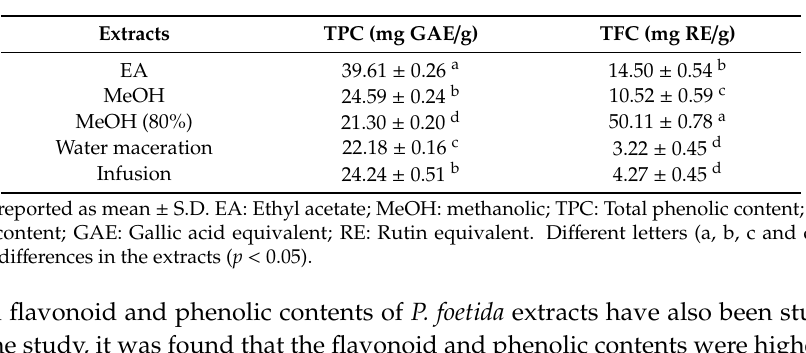
Table 1. Total phenolic and flavonoid contents of the tested